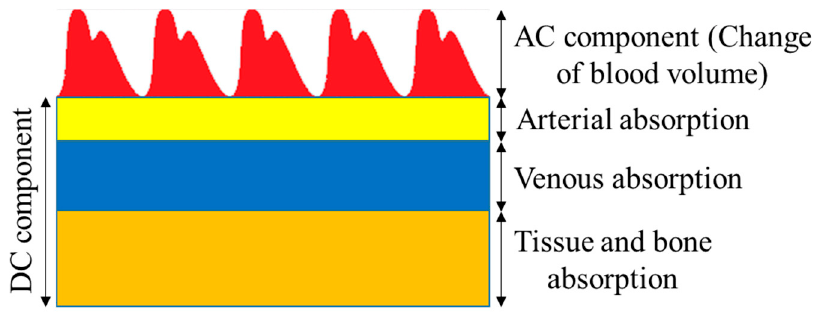
Figure 1. AC and DC components of a photoplethysmography (PPG) waveform.